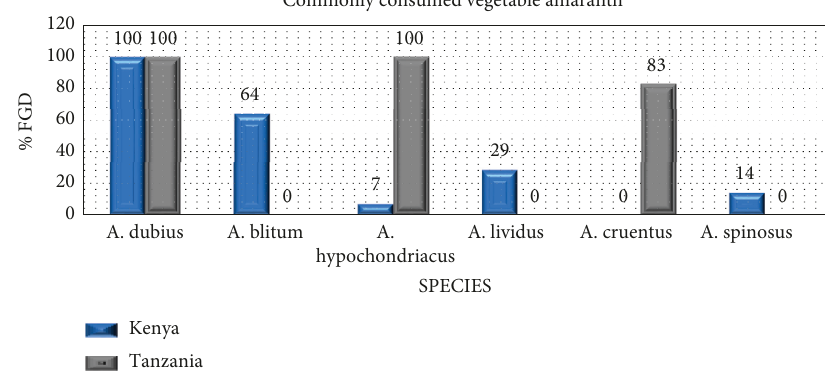
Figure 2: Common amaranth vegetables in Kenya and Tanzania.